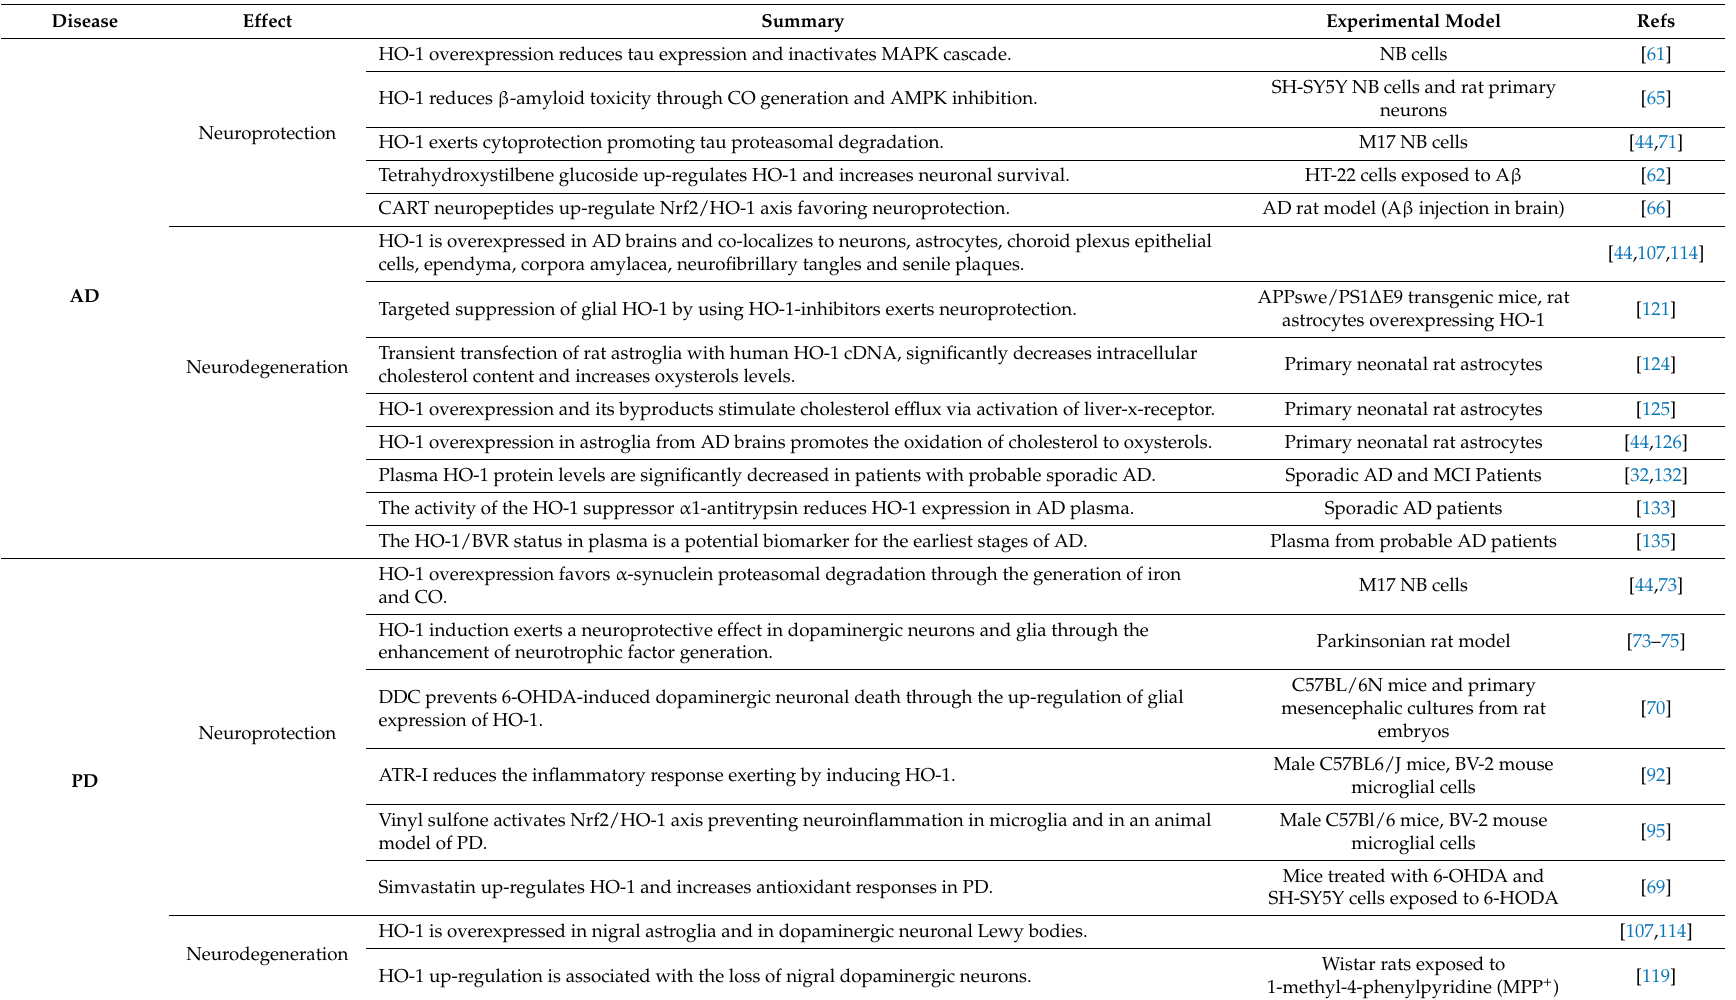
Table 1. Effects of HO-1 induction in neurological